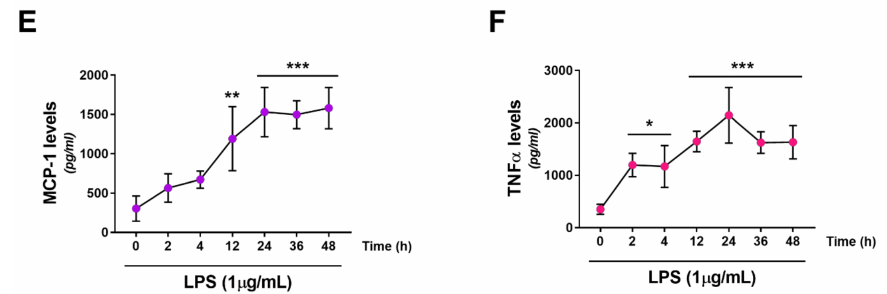
Figure 2. ( A – F ) Levels of secreted pro-inflammatory cytokine/chemokines in RT4 SCs treated with LPS at different time points (0, 2, 4, 12, 24, 36 and 48 h) were determined using commercially available Bio-Plex Pro Rat Cytokine I multiplex assay kits (for details refer to Materials and Methods section). Data shown is the result of three independent determinations ( n = 3), each run in duplicate. * p < 0.05, ** p < 0.01 or *** p < 0.001 vs. time 0, as determined by ANOVA followed by Dunnett’s post-hoc